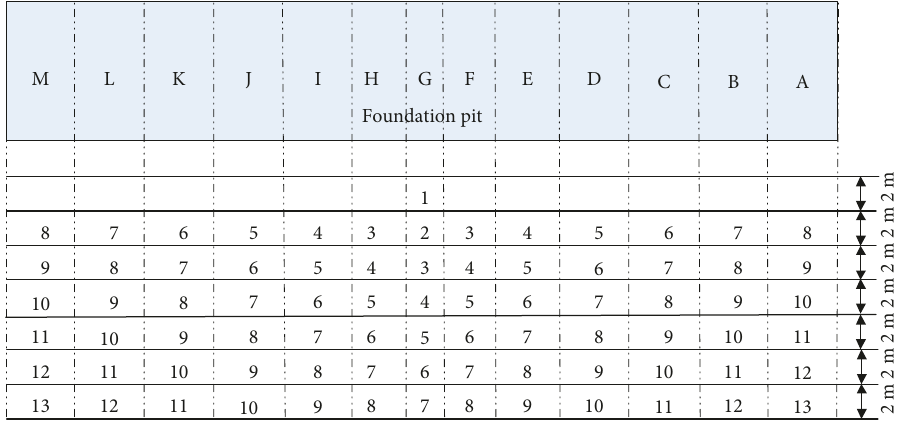
Figure 12: Third excavation mode ( W 3).